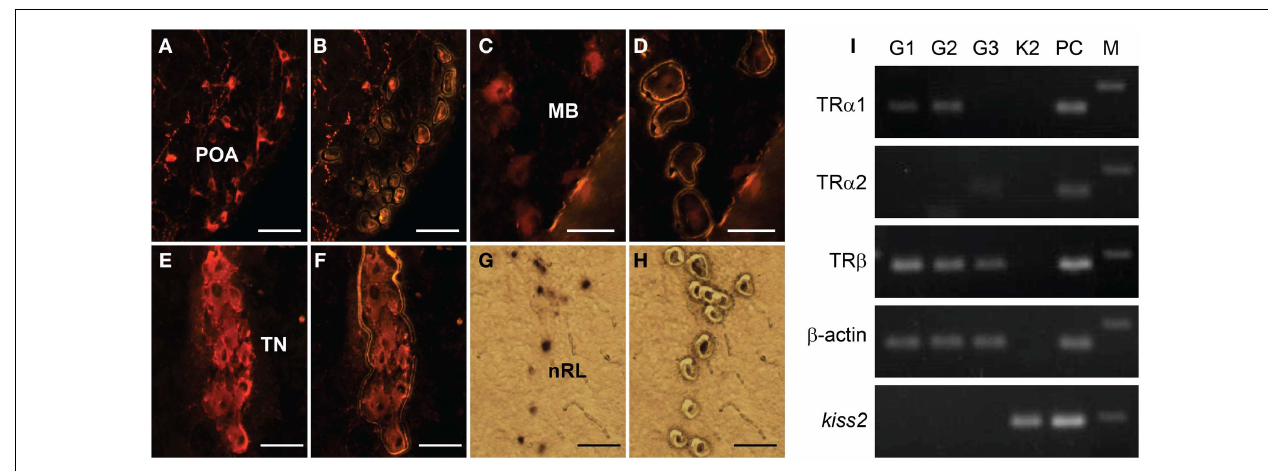
preoptic area; MB, midbrain;TN, terminal nerve; nRL, the nucleus of lateral recesses. (I) RT-PCR of the tra1 , tra2 , trb , β -actin, and kiss2 genes in the laser-captured immune-fluorescently labeled three GnRH types neurons (G1, G2 and G3) and DIG-labeled kiss2 neurons (K2). PC,Whole-brain cDNA as a positive control; M, 100-bp DNA ladder.